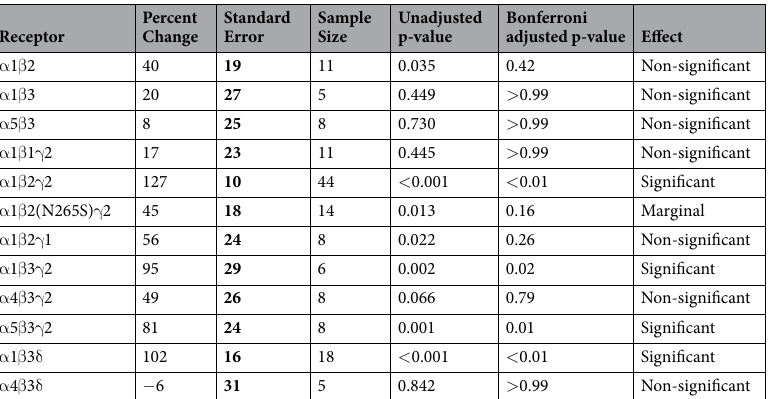
Table 2. DCUK-OEt (0.3 μ M) induced change in the response to EC 10 GABA in GABA A receptors composed of different subunit combinations. Significant and marginal effects are those with a Bonferroni-adjusted p-value < 0.05 and < 0.2, respectively. A linear mixed model was implemented in SAS (version 9.4) to calculate the normalized percent change in current for each receptor subunit combination produced by DCUK-OEt (EC 10 GABA concentration without and with 0.3 μ M DCUK-OEt). A random effect of batch was included in the model, and for each receptor, the percent change in the GABA-induced current produced by DCUK-OEt was compared to 0 using a single-sample t-test in the MIXED procedure in SAS and a Bonferroni adjustment to correct for multiple comparisons.